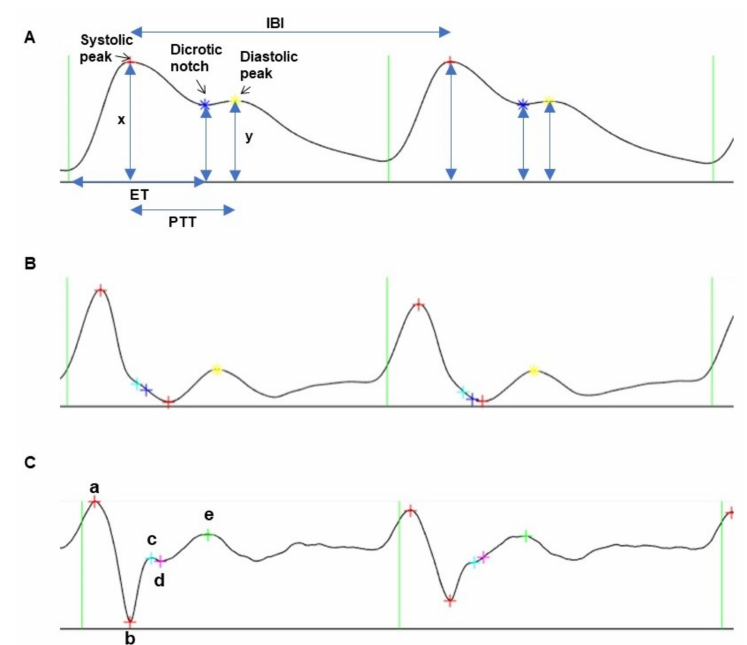
Figure 1. Pulse contour parameters calculated by the SCN4ALL system. Representative pulse wave recording (panel A ), and its first (panel B ) and second derivative curves (panel C ). ET represents ejection time measured as the duration between the foot of the pulse wave and the dicrotic notch. ET was normalized for heart rate to calculate left ventricular ejection time index (LVETI) using the formulae LVETI = 1.7 × heart rate + ET and LVETI = 1.6 × heart rate + ET in males and females, respectively. Pulse transit time (PTT) is the duration measured between the systolic and diastolic peaks of the curve. PTT was used to calculate sti ff ness index as the height of the subject over PT. IBI represents interbeat interval, which is the pulse duration measured from peak to peak. Here, x and y are amplitudes of the systolic and diastolic peaks, respectively, and are used for calculation of the reflection index as x / y. Points a–e represent notable inflection points of the second derivative curve. Second derivative inflection points were used to calculate b / a, d / a, aging index (calculated as (b − c − d − e) / a), and c–d point detection ratio (the percentage of pulse cycles in the 2-min recording in which c and d points were successfully identified by the algorithm).